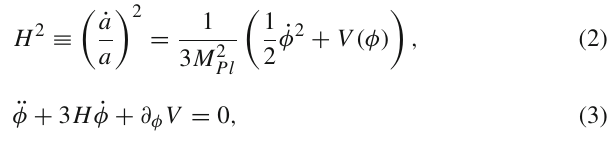
( red ), λ = − 10 − 11 ,σ = 0 . 04, and k 0 = 1 . 3 × 10 − 3 ( green ), and λ = − 1 . 5 × 10 − 11 ,σ = 0 . 04, and k = 1 . 2 × 10 − 3 ( orange ). The 0 dashed lines correspond to the featureless slow-roll